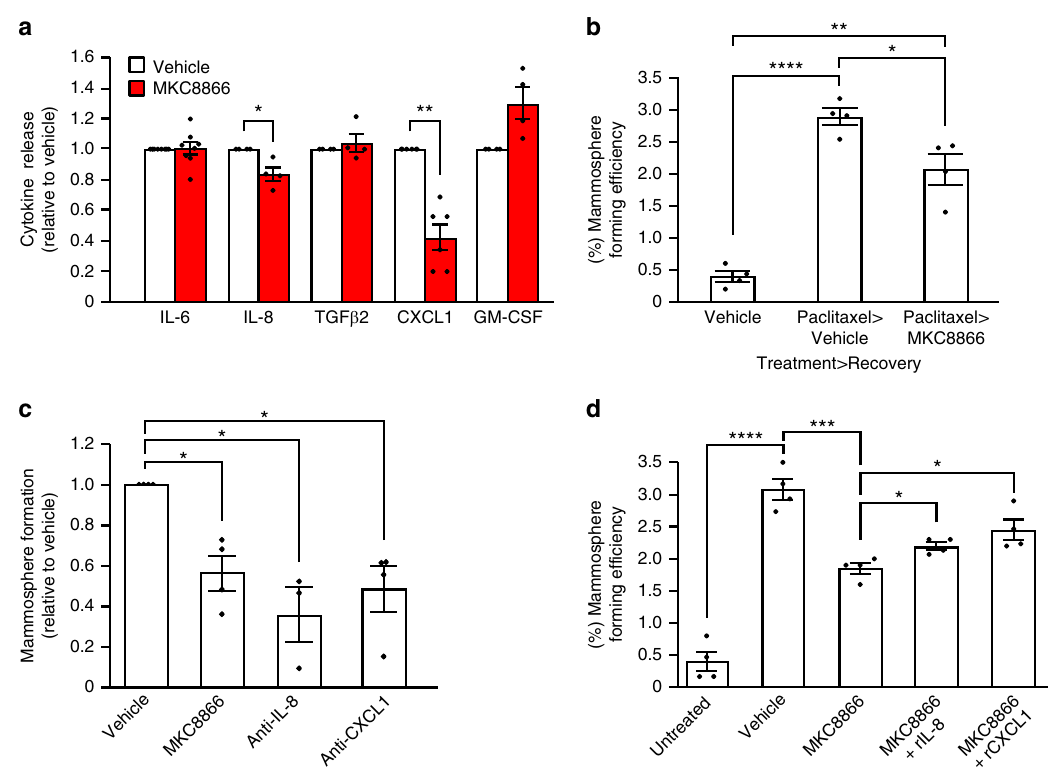
Fig. 6 Paclitaxel alteration of secretome enhances mammosphere formation. a – d MDA-MB-231 cells were treated with paclitaxel (10 nM) for 72 h, after which paclitaxel-containing medium was removed and cells were washed. a , b Cells were incubated for a further 72 h in fresh medium containing vehicle alone or MKC8866 (20 μ M). a Conditioned medium was collected and levels of IL-6 ( n = 7), IL-8 ( n = 4), TGF β 2 ( n = 4), CXCL1 ( n = 6), and GM-CSF ( n = 4) were quanti fi ed by ELISA. Cytokine release was normalized to that of vehicle-only treated controls. b After treatment, cells were seeded at equal densities onto low-adherence plates and mammospheres quanti fi ed after a further 5 days ( n = 4). c , d Fresh medium containing vehicle alone, MKC8866 (20 μ M), c neutralizing antibodies against CXCL1 (10 μ g ml − 1 ) or IL-8 (500 ng ml − 1 ) ( n = 4), d MKC8866 (20 μ M) plus recombinant CXCL1 (rCXCL1, 500 pg ml − 1 ) or recombinant IL-8 (rIL-8, 3 ng ml − 1 ) was added and cells incubated for an additional 72 h. Cells were seeded at equal densities onto low- adherence plates and mammospheres quanti fi ed after a further 5 days ( n = 4). * P < 0.05, ** P < 0.01 and *** P < 0.001, based on a Student ’ s t test. Error bars represent